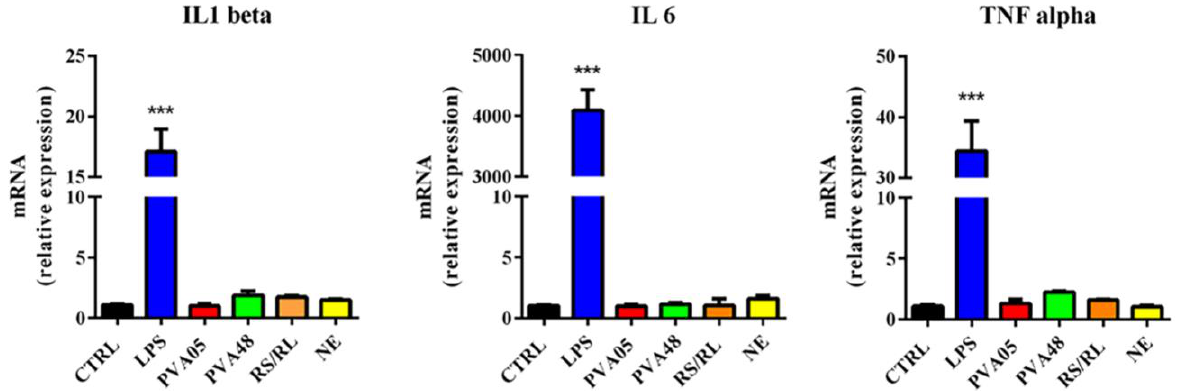
Figure 6. Proinflammatory cytokine expression in THP-1-derived macrophages exposed to uncoated PVA05- and PV48-based specimens and to Eudragit ® RS/RL- and Eudragit ® NE-coated ones. THP-1 cells differentiated into macrophage by the incubation with PMA for 24 h were exposed to the different samples for 48 h. Untreated macrophages (CTRL) and LPS treated macrophages were used as negative and positive controls, respectively. IL1 beta, IL6 and TNF alpha expression was analyzed by RT-PCR. Values are expressed as mean ± SEM ( n ≥ 3) normalized versus CTRL (*** p < 0.001 versus CTRL).